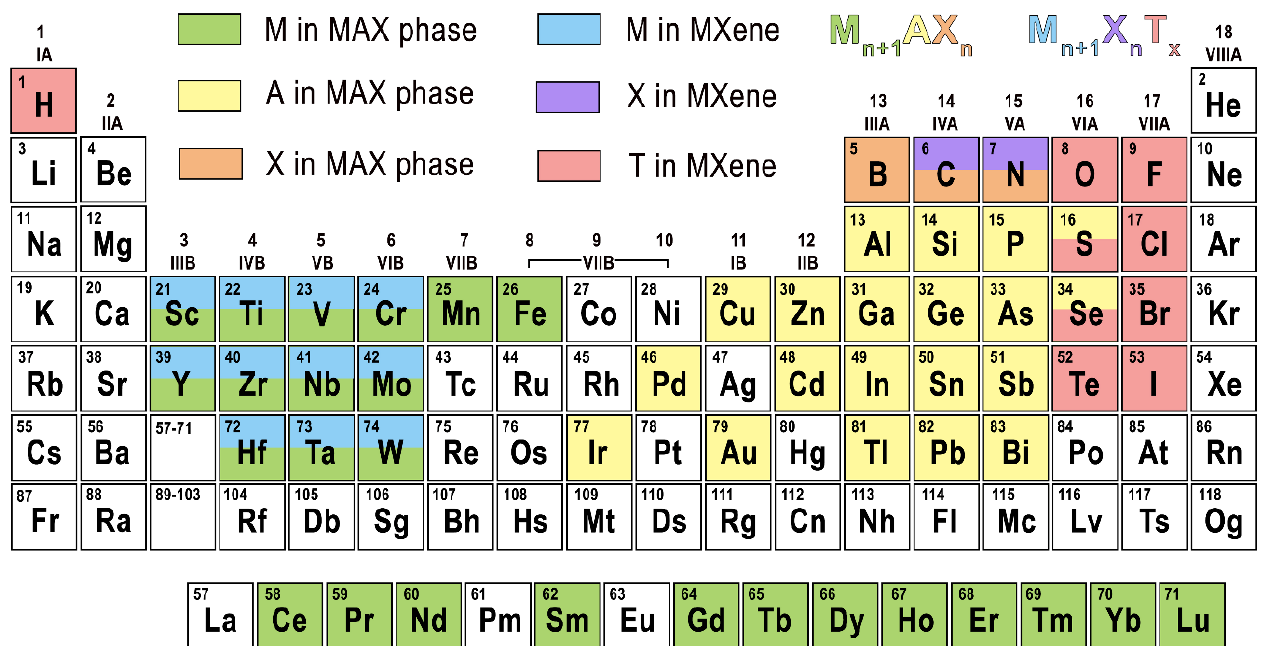
Figure 2. Elements of the known MAX phases and MXenes. A green background indicates the metals (M elements) that are used only to obtain MAX phases, but no MXene has been yet synthesized with them; the elements in M positions that have been successfully used for the synthesis of MXenes are highlighted in blue. The known elements A of the MAX phase layers are marked with a yellow background. X elements in MAX phases and MXenes are highlighted in orange and purple, respectively. Red background shows functional surface groups in MXenes.